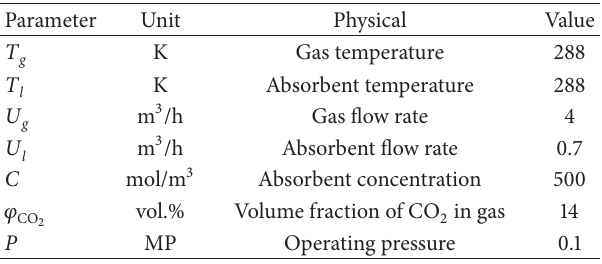
Table1:SpecificationsandparametersofPPhollowfibermembrane Table 2: Parameters of operating